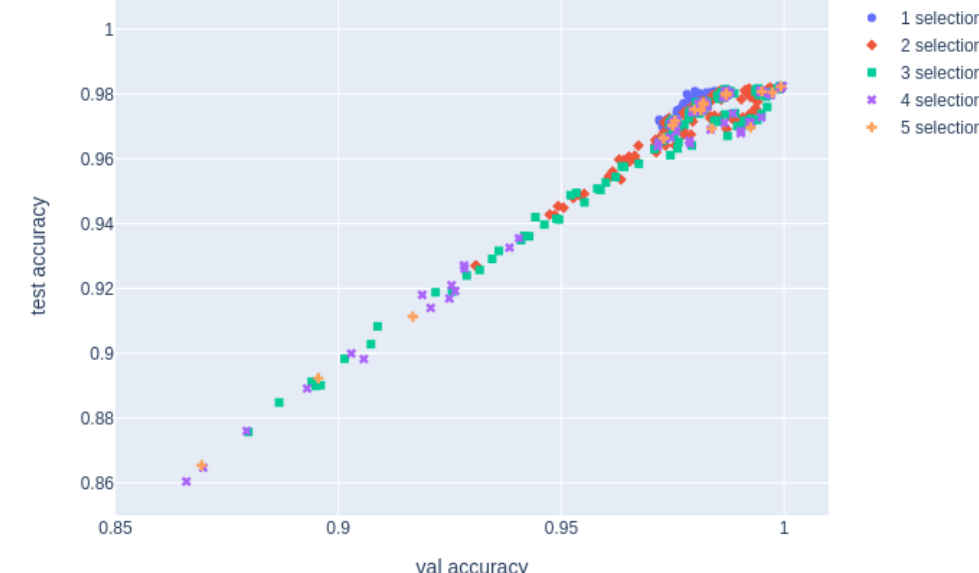
Figure 3. Comparison of uniform soups validation and test data accuracies for models with different training and validation data. We selected n ∈ { 1, · · · , k } models from different training and validation data with the same hyperparameters and compared the results of applying uniform soups to the n models. Table 2. Correlation coefficients between validation accuracy and test accuracy for each number of models to be merged in uniform soups. “corr for all” is the correlation coefficient for all models, and ”corr over thre” is the correlation coefficient for models whose evaluation accuracy is above a certain threshold. The threshold is the lowest validation accuracy of the models before merging. n Corr for All Corr over Thre 1 0.878 0.934